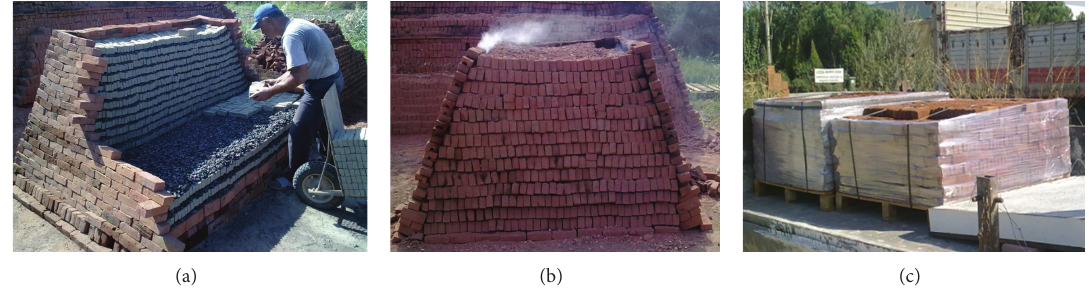
Figure 2: The masonry bricks ready to use and stacked with coal.